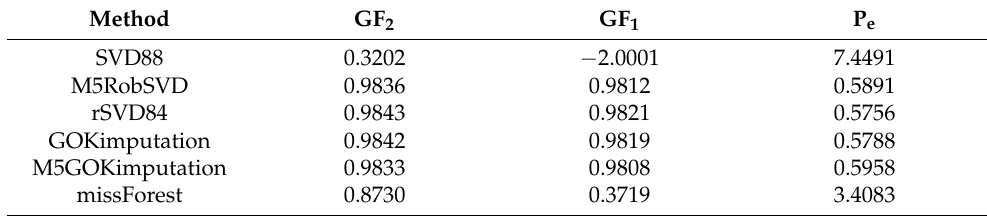
Table 3. Results of numerical example